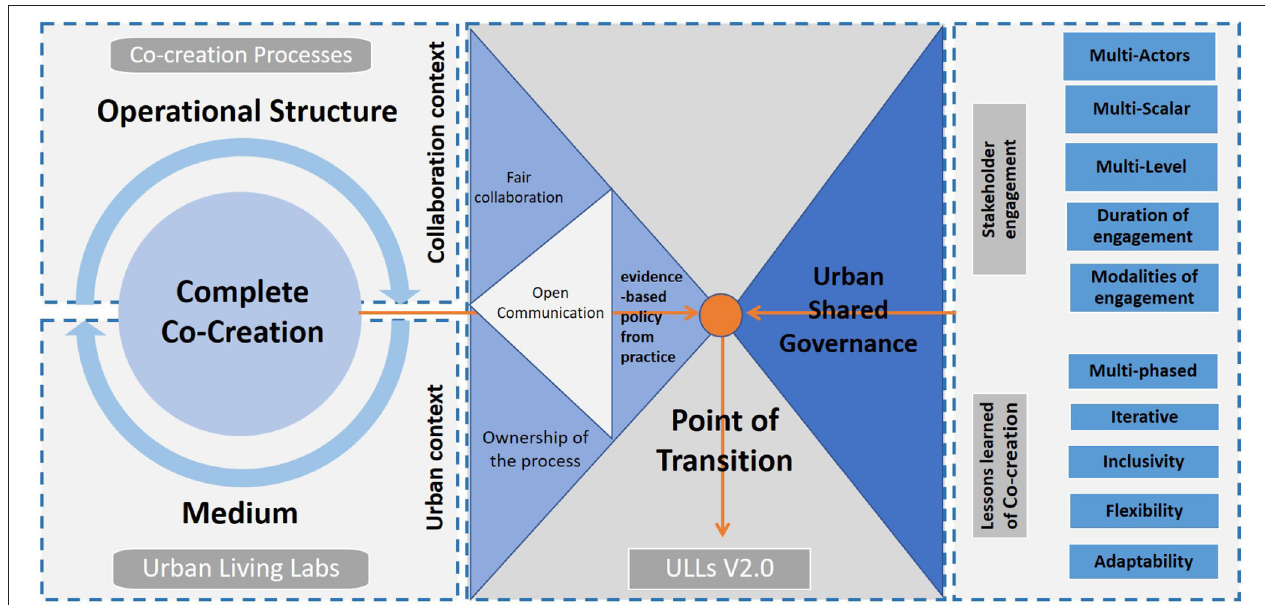
FIGURE 1 | The Co-creation transition model of inclusive shared governance toward ULLs V2.0. Source: the authors inspired by Jansen and Pieters (2017) and Mahmoud and Morello